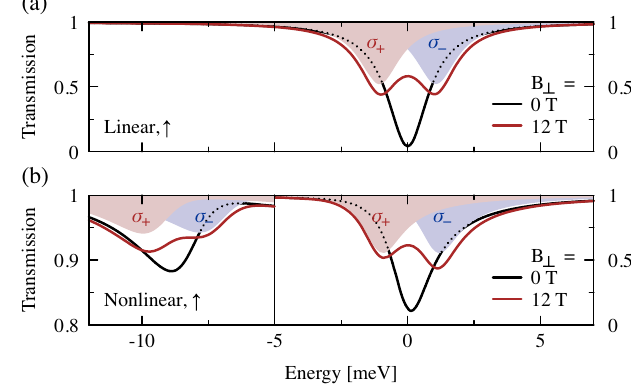
FIG. 6. (a) Linear (pulse area Θ → 0 ) and (b) nonlinear (pulse area Θ ¼ 0 . 1 π ) transmission spectra for linearly ( ↑ ) polarized excitation with 40 fs pulses (intensity FWHM) for a monolayer of MoS 2 at 5 K for a magnetic field B ⊥ of 0 or 12 T. The laser pump ϵ energy ℏ ω is resonant to the exciton resonance energy at p ¼ x B ⊥ ¼ 0 T. The solid lines represent the linearly polarized trans- mission and the shaded areas the underlying σ